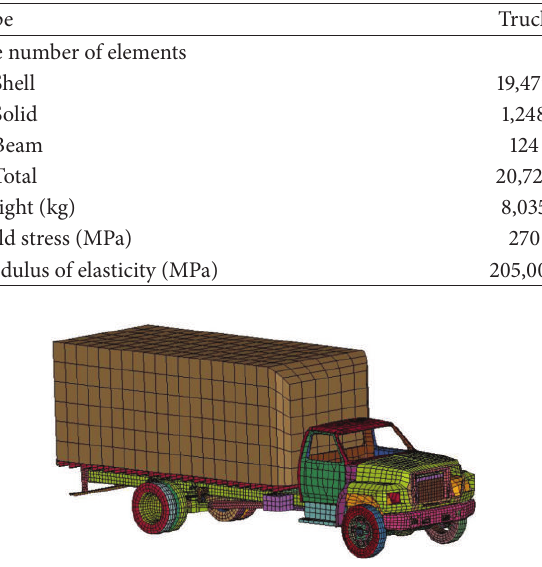
Figure 1: Condition of impact severity.